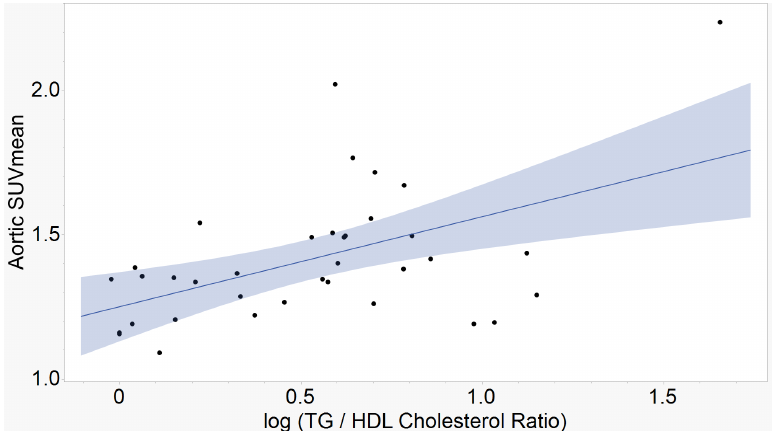
Figure 4. Aortic SUVmean vs. Atherogenic Index of Plasma (AIP). Calculated as log(triglycerides/HDL cholesterol), the AIP demonstrates a moderate, positive correlation with mean tracer uptake in the aorta. (r = 0.51, p = 0.00152, n =